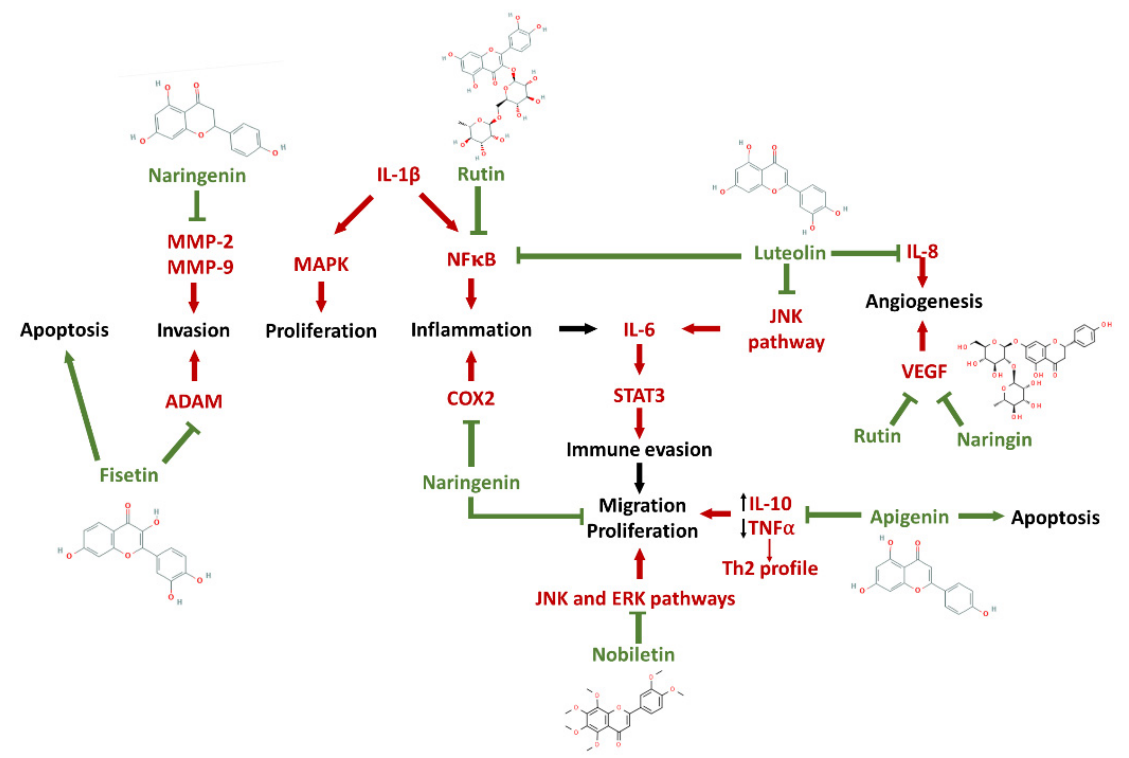
Figure 4. A schematic representation of the possible mechanisms of action of selected flavonoids. Note that these flavonoids act in different signaling pathways, reducing inflammation, migration, proliferation, invasion, angiogenesis and inducing apoptosis in tumor cells. Table 2. Some flavonoids that act in different signaling pathways in glioma cells.